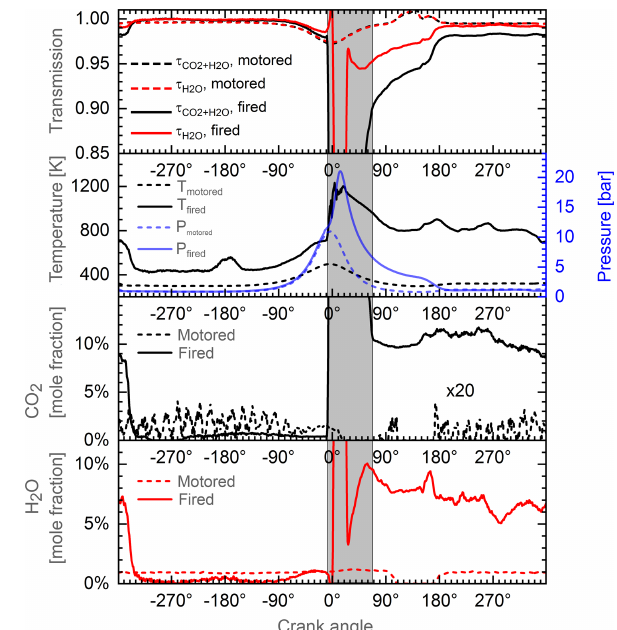
Figure 8. Measurements of CO 2 and H 2 O concentrations in a methane-fueled IC engine. Dashed lines: motored operation with laboratory air. Solid lines: fired operation with methane port-fuel in- jection at a global λ = 1 (stoichiometric combustion). The gray area indicates time of combustion, which is excluded from the data in- terpretation due to partial saturation of the detectors from the flame